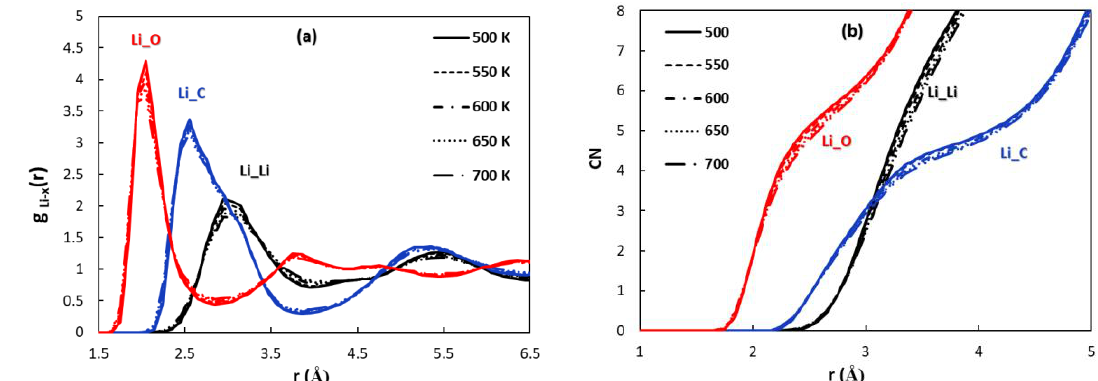
Figure 3. Radial distribution functions (RDFs) obtained from MD simulations of ( a ) amorphous Li 2 CO 3 as a function of temperature. ( b ) Coordination numbers (CN) obtained from integration of g(r)s from panel ( a ).